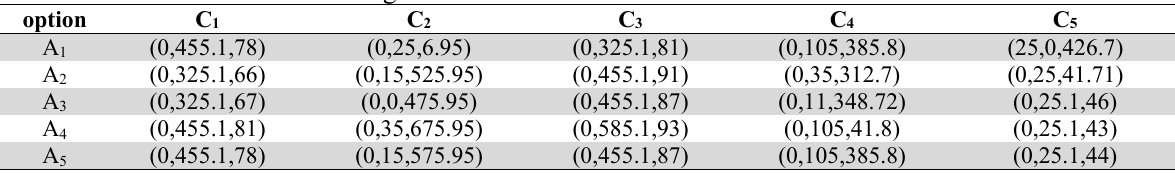
Results of descaled decision-making matrix